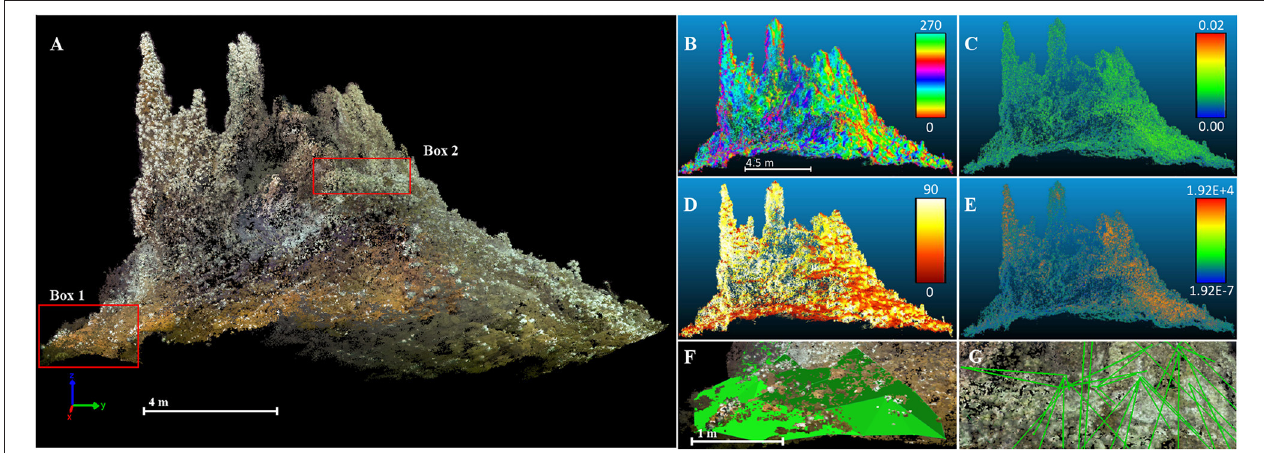
FIGURE 3 | South side of reconstructed 3D textured dense point cloud and derived terrain variables. (A) Textured dense point cloud of the reconstructed chimney. (Box 1) delineates the outline of the extracted frame (F) ; (Box 2) delineates the outline of the extracted frame (G) . All following terrain variables were calculated at a radius of 0.02m. (B) Aspect of chimney. (C) Roughness. (D) Slope. (E) Gaussian surface curvature. (F) Surface area measurement. Green surface indicates the measured area. (G) Distance measurements to black and diffuse fluids.